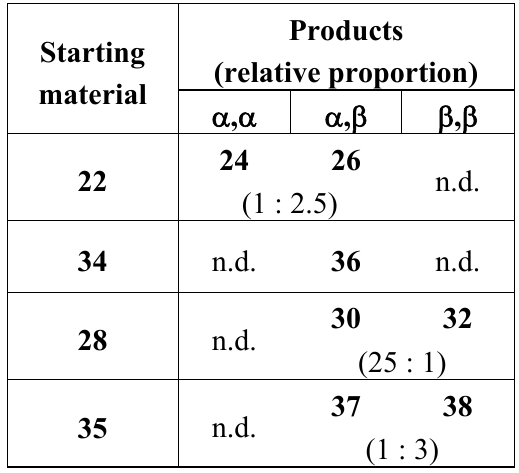
Table 2 . Comparative results for DFA formation from D -fructose precursors bearing acyclic and cyclic benzyl-type protecting groups (n.d., not